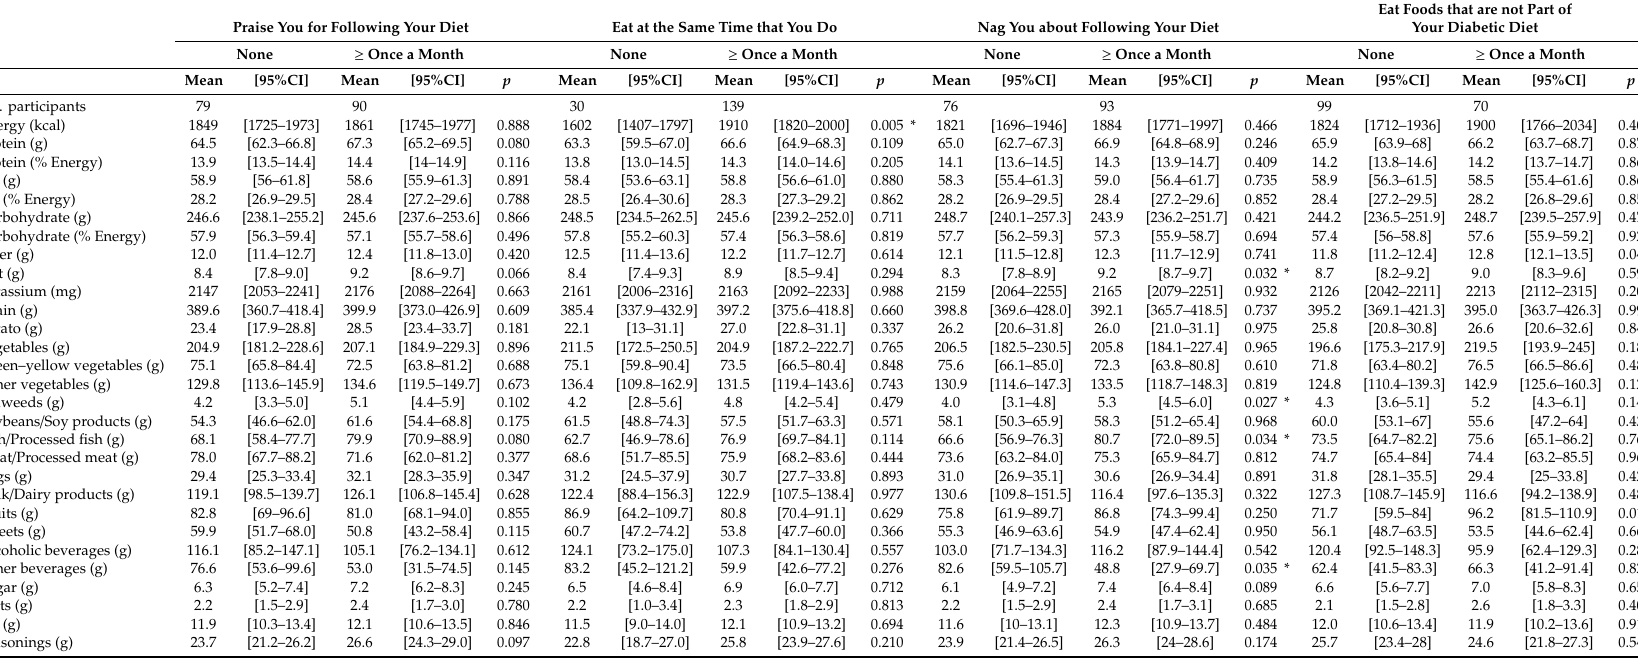
Table 3. Dietary intake and response to the Diabetes Family Behavior Checklist scale for medical nutritional therapy in men with type 2 diabetes ( N =